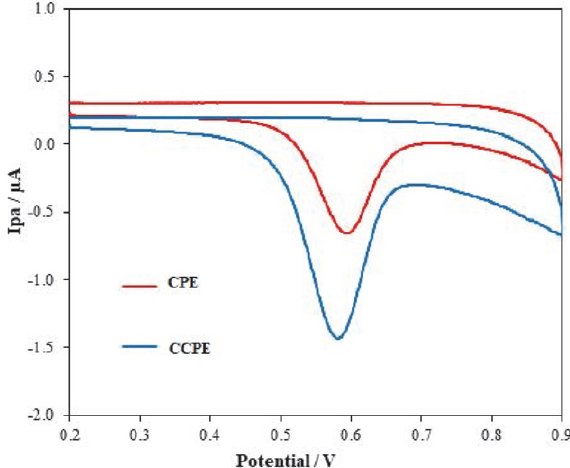
Figure 4. CVs of 1.0 µM KC at CPE and CCPE electrodes (υ: 0.1 V/s, 0.04 M BR buffer, pH 9.0).